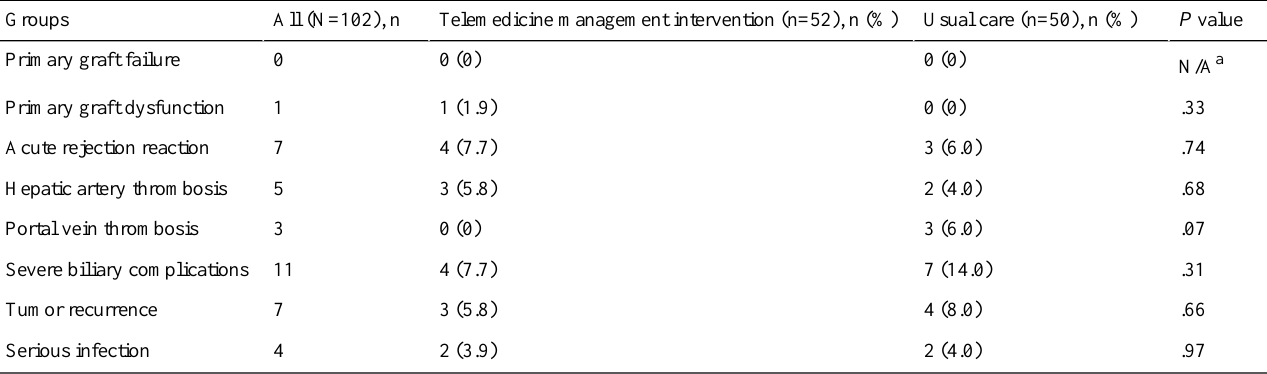
Table 2. Major complications after liver transplantation of patients at the 12-month follow-up visit in the two groups.